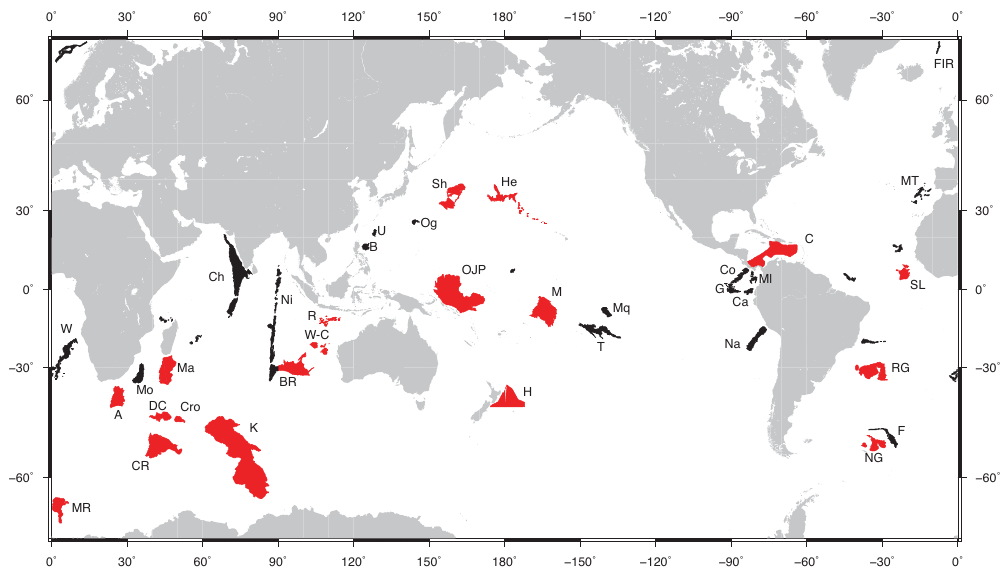
Figure 4. Location map of oceanic plateaus (shown in red) and submarine ridges (shown in black). Updated from LIP list of Coffin and Eld- holm (1994) based on the definition of Bryan and Ernst (2008). Oceanic plateaus and submarine ridges labeled in the figure are: A –